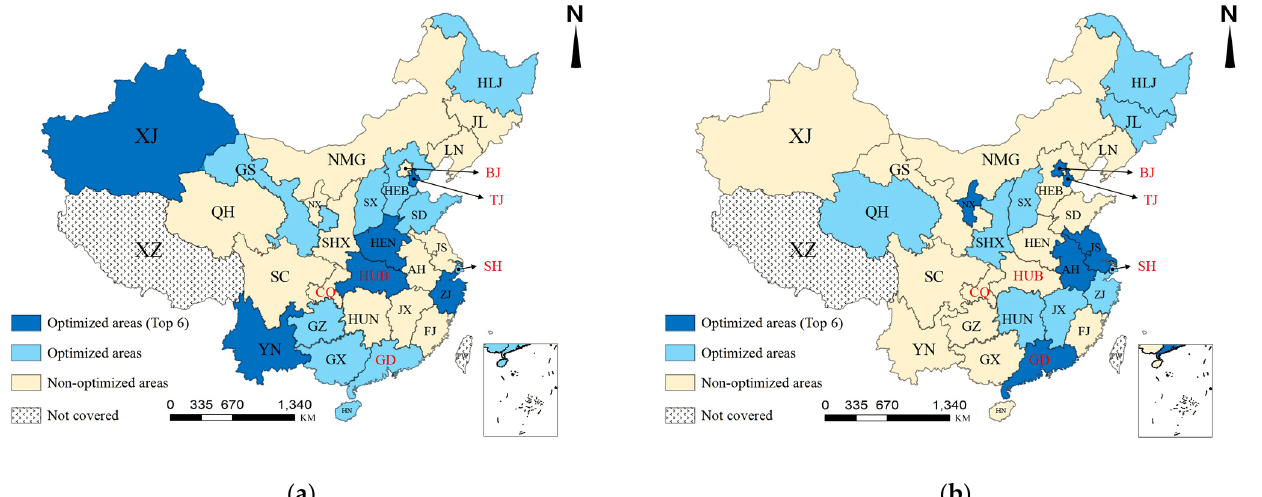
Figure 6. Spatio-temporal evolution distribution of land use transition at the economical dimension. ( a ) Differences between the CETS implementation process and before implementation; ( b ) differences between the CETS post-implementation and implementation process.